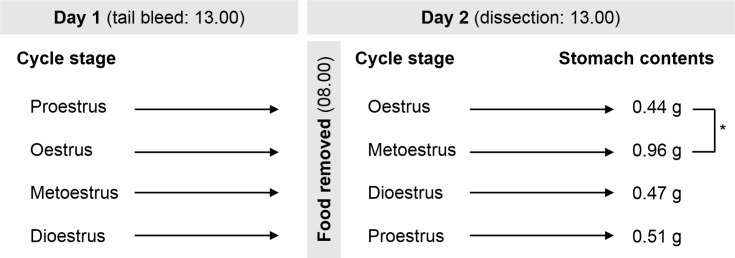
The mass of fasted stomach contents after each stage of the oestrous cycle.The reduced stomach contents seen after proestrus/oestrus was significantly less than after oestrus/metoestrus, indicating reduced earlier food and water consumption. (Cull cycle stages: proestrus, n = 12; oestrus, n = 11; metoestrus, n = 9; dioestrus, n = 11. *P<0.05).